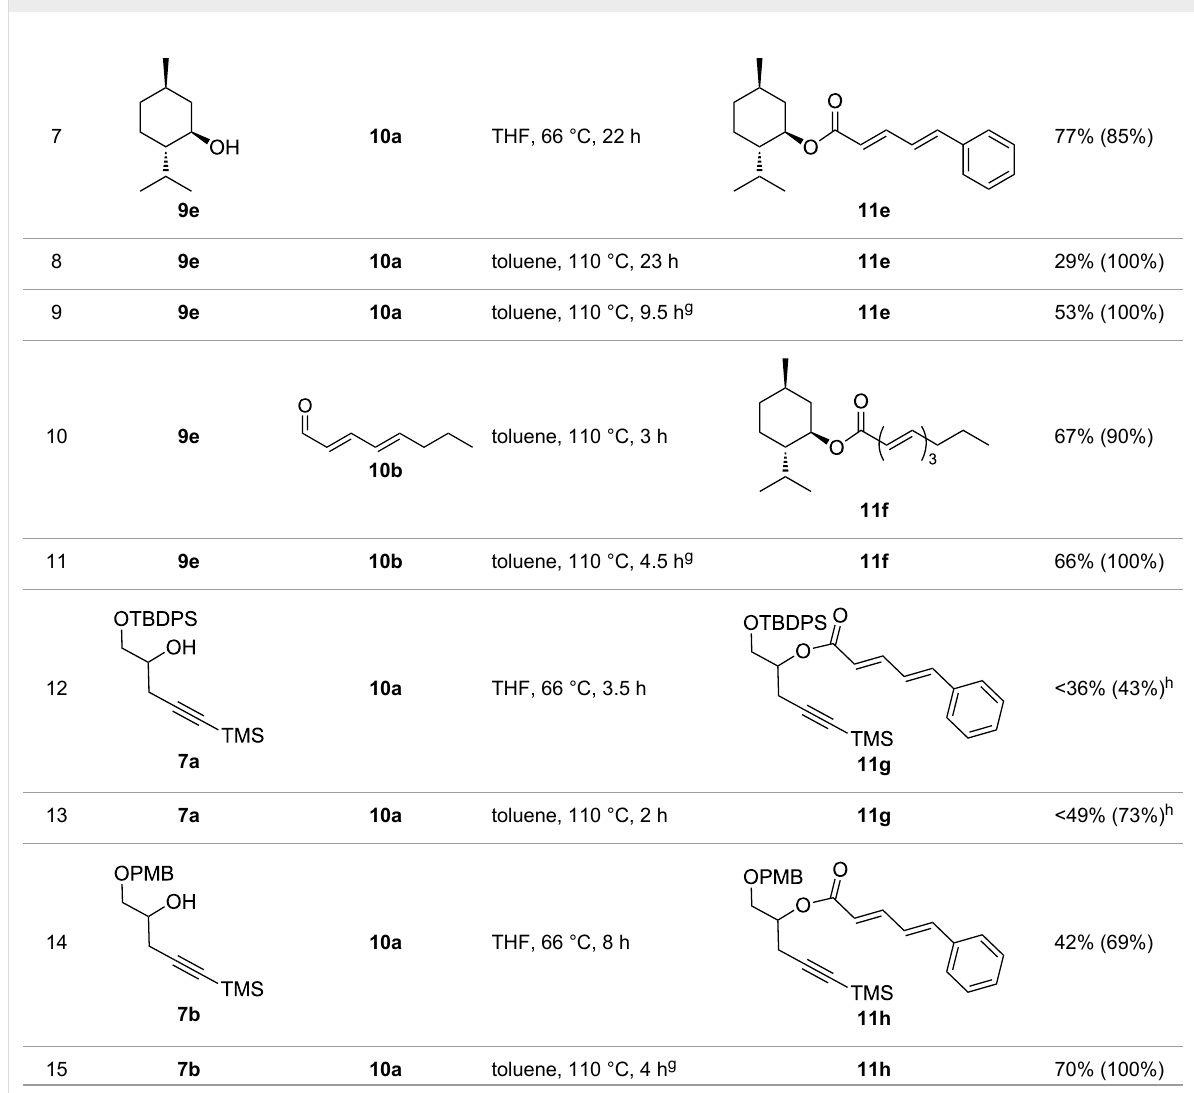
Table 1: Coupling reactions of alcohols 9 and aldehydes 10 with Bestmann ylide ( 1 ) a .